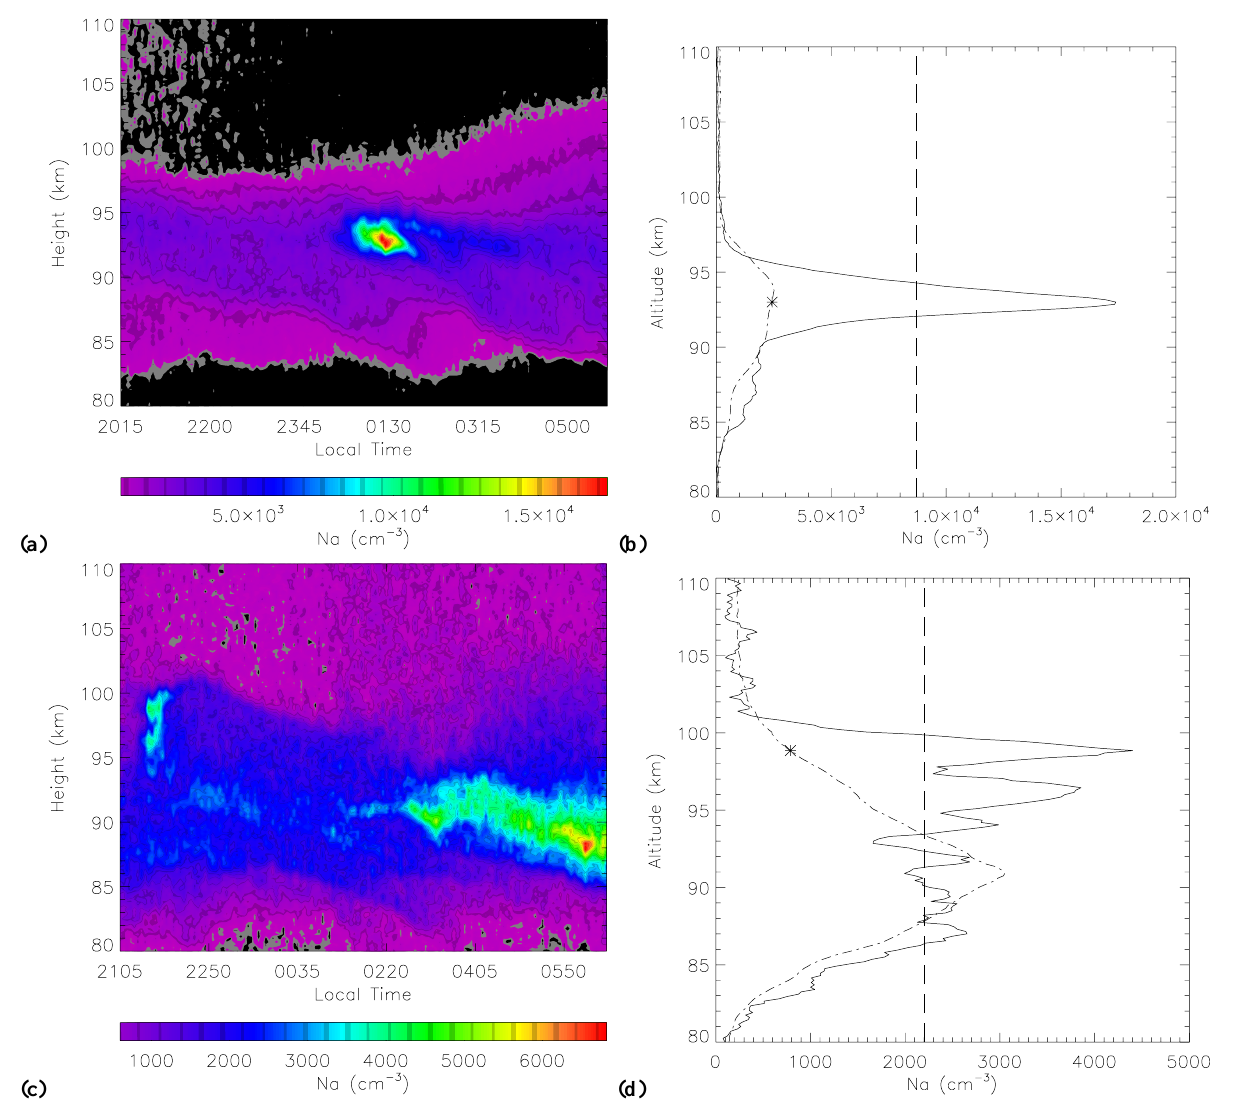
Fig. 1. Examples of the contour plots and the corresponding profiles at their maximum values of SSL events. (a–b) represent the SSL event on 20 March 2007, and (c–d) represent the SSL event on 27 January 2007. The dot-dashed lines in (b) and (d) indicate the averaged background sodium densities; the stars mark the background sodium densities corresponding to the sporadic sodium peak densities. The dashed lines show the half maximum values of the peak